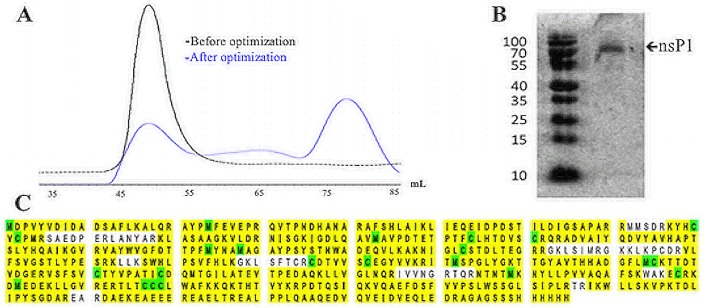
Validation of CHIKV nsP1 purity and identity.Recombinant CHIKV nsP1 was purified with 6X his-mediated affinity chromatography followed by size exclusion chromatography. (A) Early attempts to purify CHIKV nsP1 resulted in highly aggregated protein that eluted exculsively in the void volume (eluted around 55 mL) during gel filtration, while protein purified after optimization of expression and purification conditions eluted around 72 mL. (B) Eluates resulting from size exclusion chromatography were concentrated and analyzed with SDS-PAGE gel electrophoresis and Coomassie staining. (C) This band was cut out, digested with trypsin and analysed further with orbitrap mass spectrometry analysis.